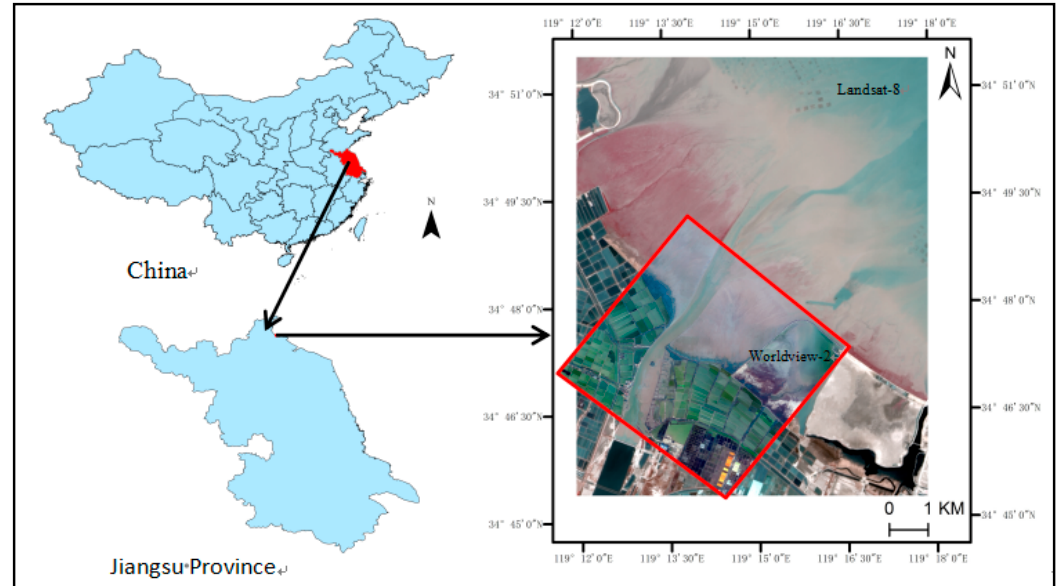
Figure 1. Study area.